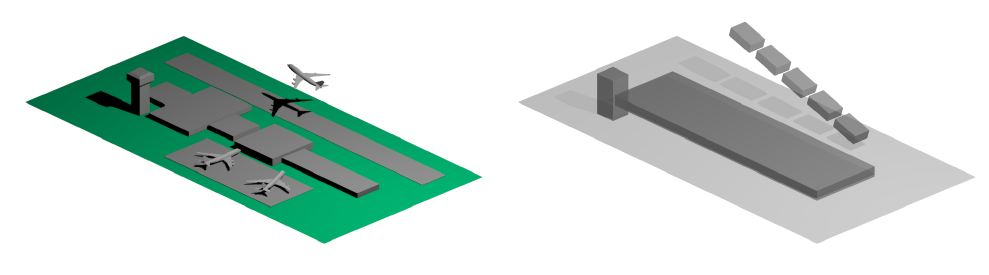
Figure 3. Simplification of the air traffic system via a continuous model approximation ( left ) to a discrete data aggregation ( right